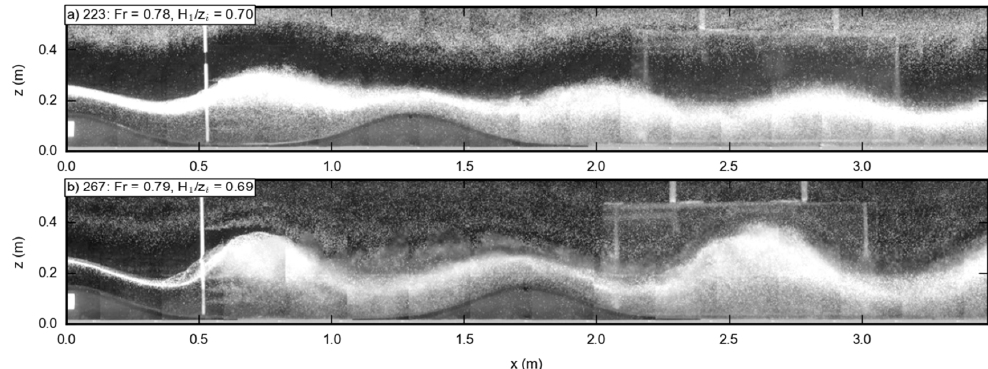
Figure 8. Examples of ( a ) destructive and ( b ) constructive lee-wave interference for ( a ) shorter 1.3 m and ( b ) longer 1.8 m valley width.